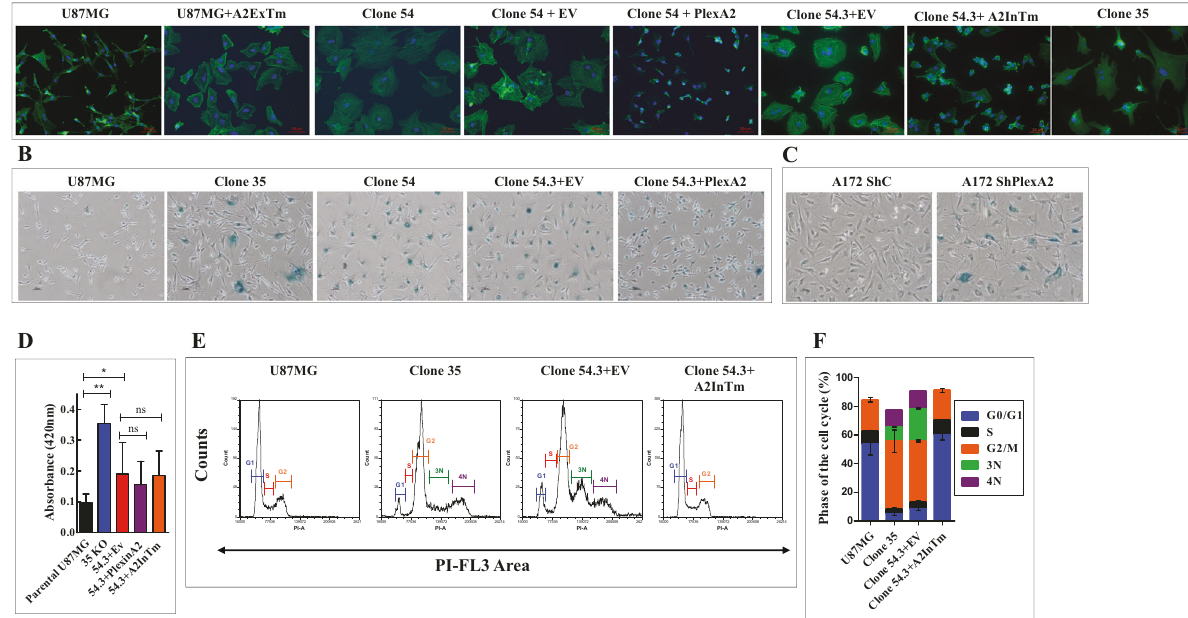
Fig. 5 U87MG cells in which the plexin-A2 gene was knocked out acquire some properties of senescent cells. A The indicated cell types were seeded on fi bronectin-coated coverslips and stained with DAPI to visualize cell nuclei (blue) and with fl uorescent phalloidin (green) to visualize actin fi bers. Shown are merged confocal photographs generated using ZEN 2.3 software. B-C The indicated cell types were assayed at pH-6 for the expression of the senescence marker SA- β galactosidase as described in materials and methods. Shown are representative photographs. D Equal numbers of U87MG cells ( N = 9 independent experiments), plexin-A2 knock out U87MG cells (clone 54.3 ( N = 7), clone 35 ( N = 3)) or clone 54.3 cells in which full-length plexin-A2 (PlexinA2) (N = 5) or A2InTm ( N = 5) were re-expressed, were collected and lysed